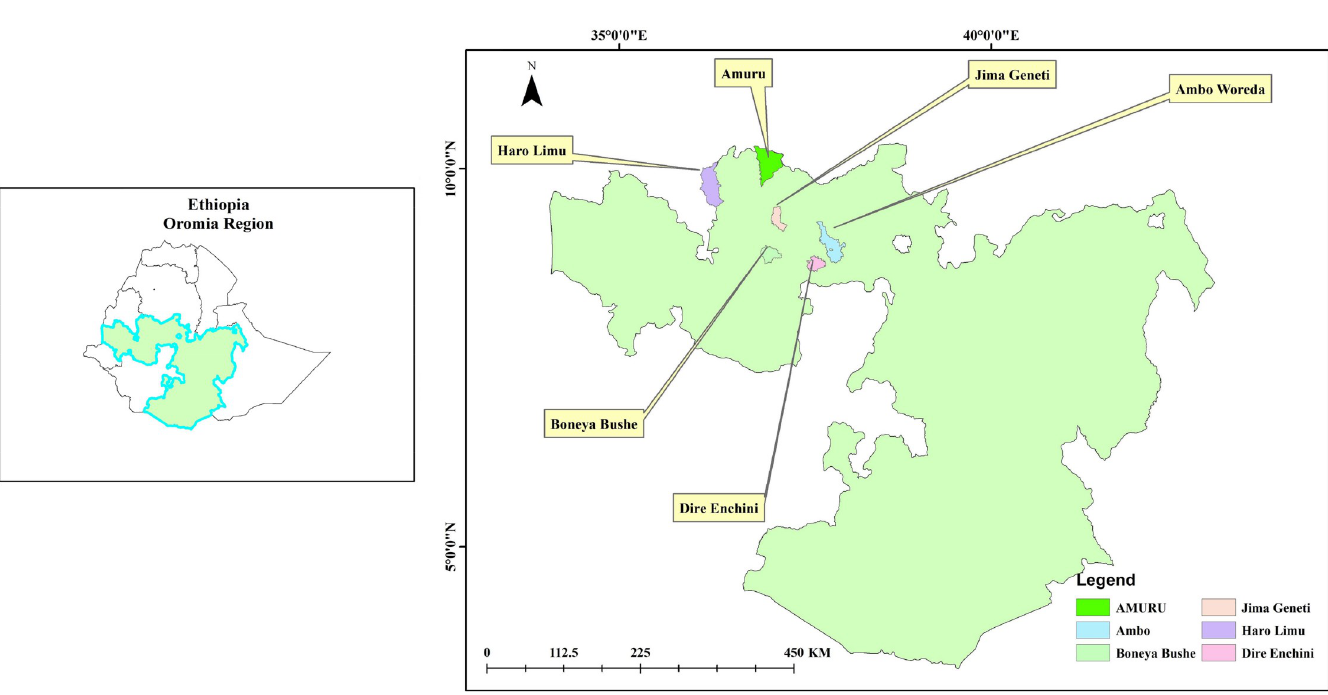
Fig 1. Map showing the six survey districts of Oromia Regional state, Ethiopia,